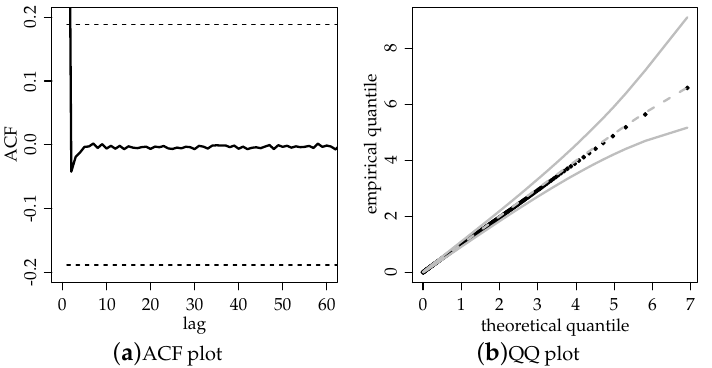
Figure 1. Autocorrelation function (ACF) plot and quantile-against-quantile (QQ) plot with envelope for the residuals.